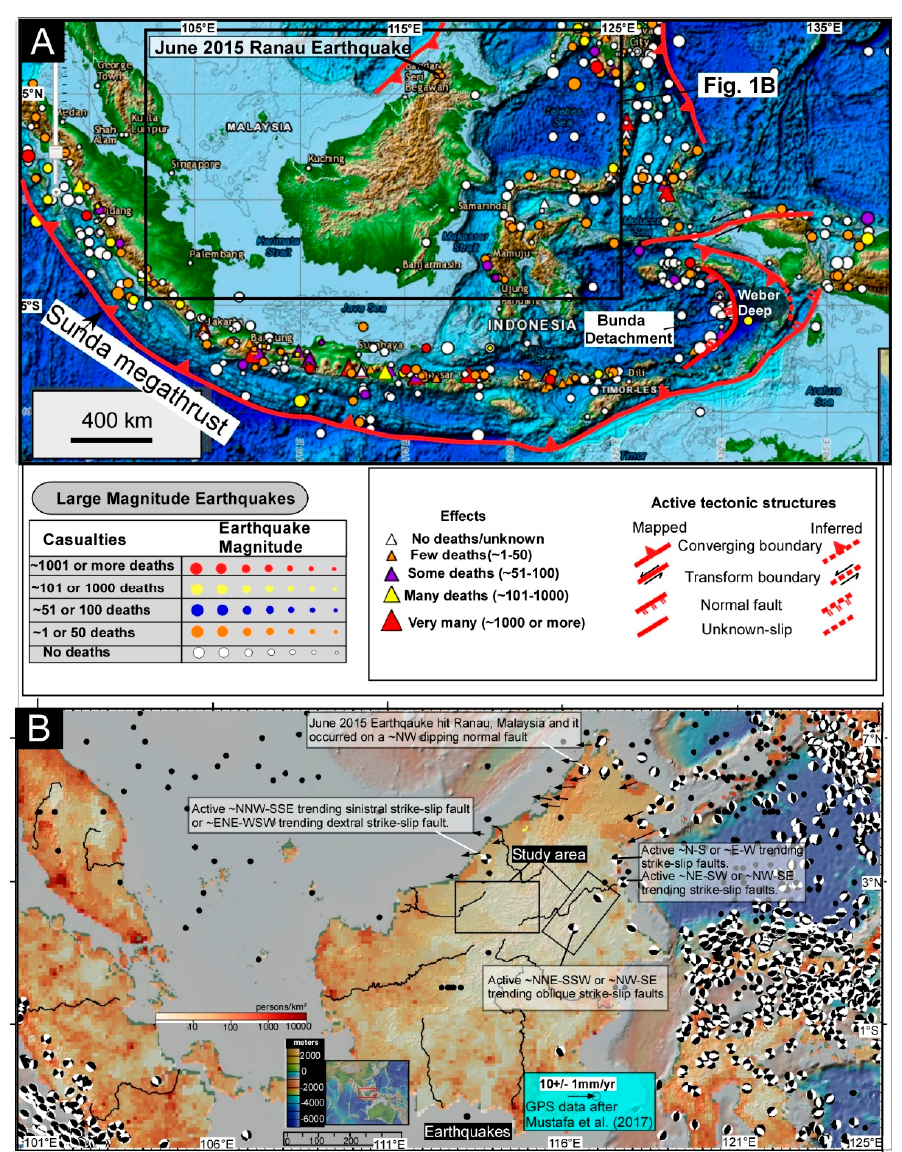
Figure 1. ( A ) The regional tectonic setting of Borneo, and the location of significant earthquakes and volcanoes in the region. ( B ) The available earthquake fault plane solutions that are plotted on the satellite image. The earthquakes around the study area are mostly strike-slip. The world population data are plotted on the satellite image and it highlights the pockets of dense population and their vulnerability to earthquake hazards. Map is created in GeoMap